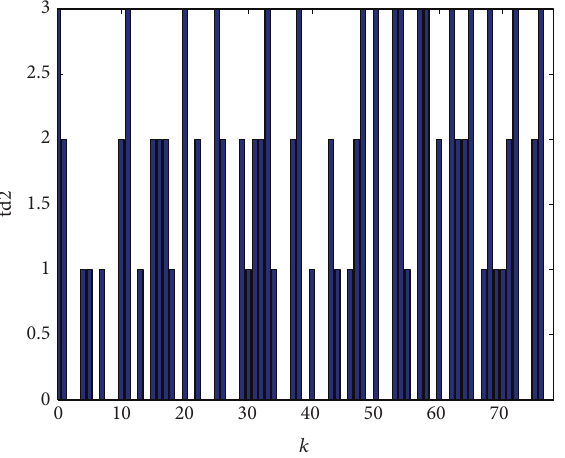
Figure 18: Bounded arbitrary time delays (Example